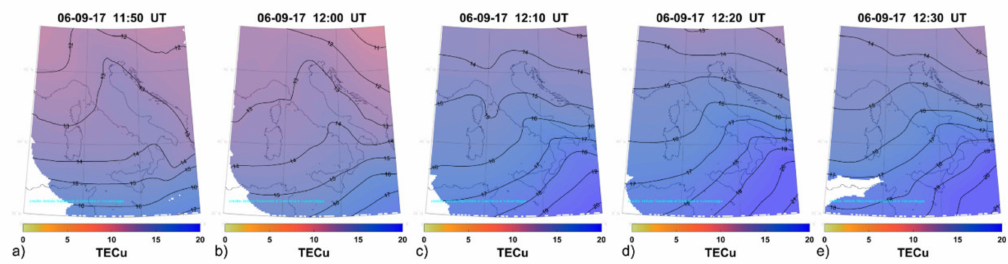
Figure 10. TEC maps for the times between 11:50 UT (panel a ), 12:00 UT (panel b ), 12:10 UT (panel c ), 12:20 UT (panel d ) and 12:30 UT (panel e ) for 6 September 2017, during which the X9.3 flare occurred.